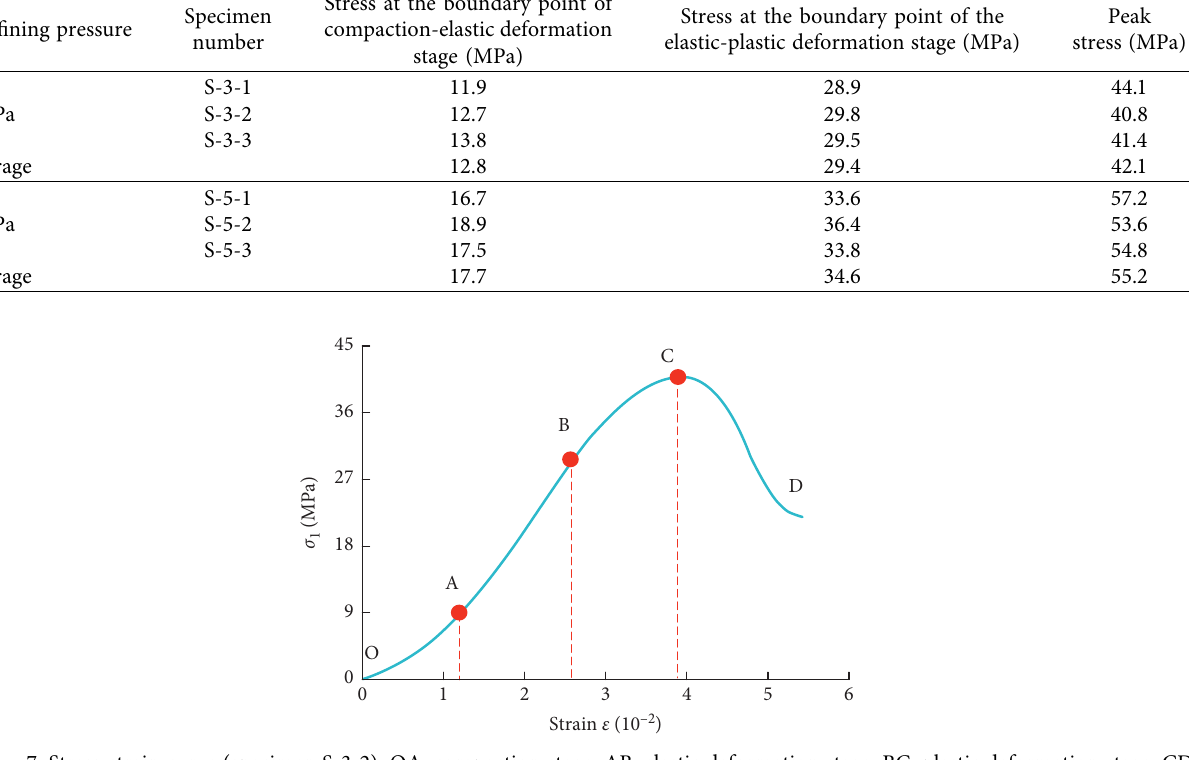
Figure 7: Stress-strain curve (specimen S-3-2). OA: compaction stage; AB: elastic deformation stage; BC: plastic deformation stage; CD: residual deformation stage.